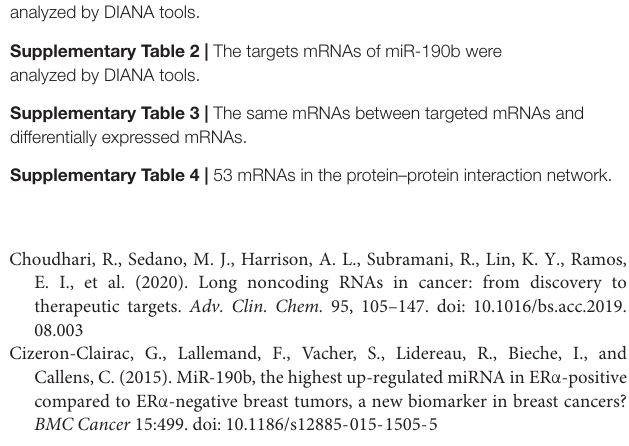
Supplementary Table 1 | The targets miRNAs of LINC01235 were analyzed by DIANA tools. Supplementary Table 2 | The targets mRNAs of miR-190b were analyzed by DIANA tools. Supplementary Table 3 | The same mRNAs between targeted mRNAs and differentially expressed mRNAs. Supplementary Table 4 | 53 mRNAs in the protein–protein interaction